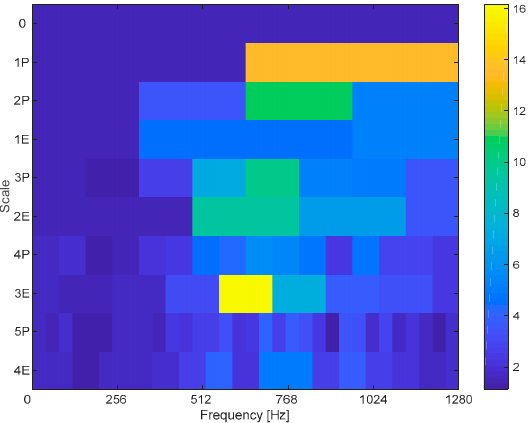
Figure 33. EEMD decomposition results of the displacement signal.